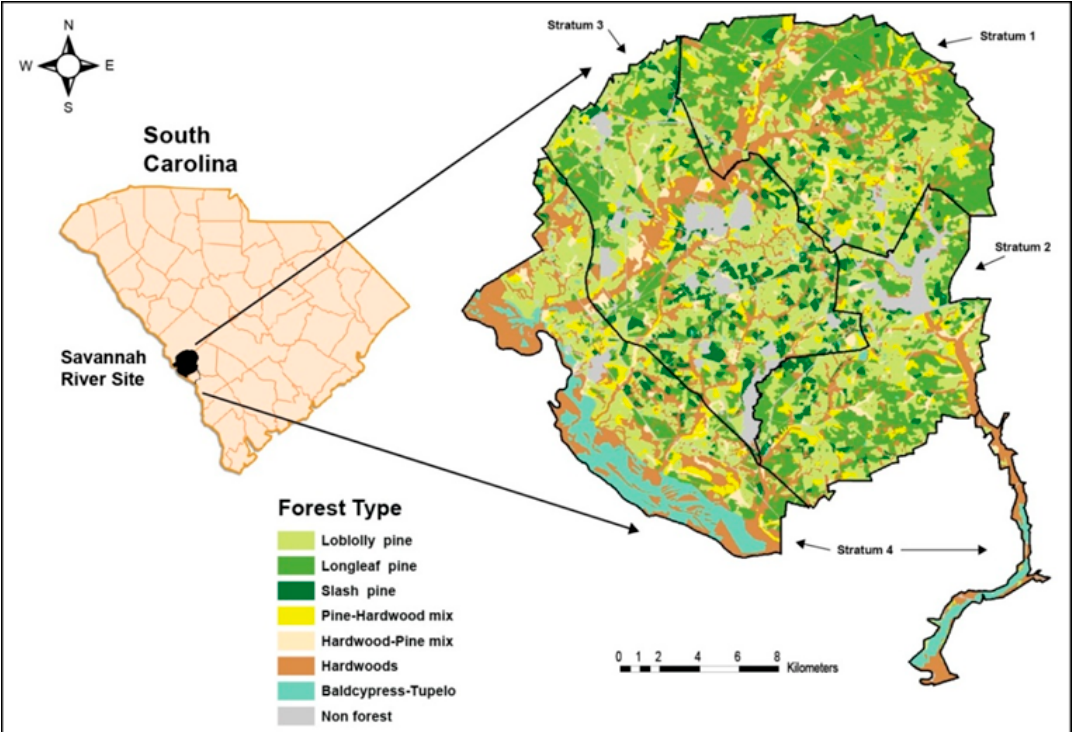
Figure 1. Map of forested areas of the Savannah River Site.